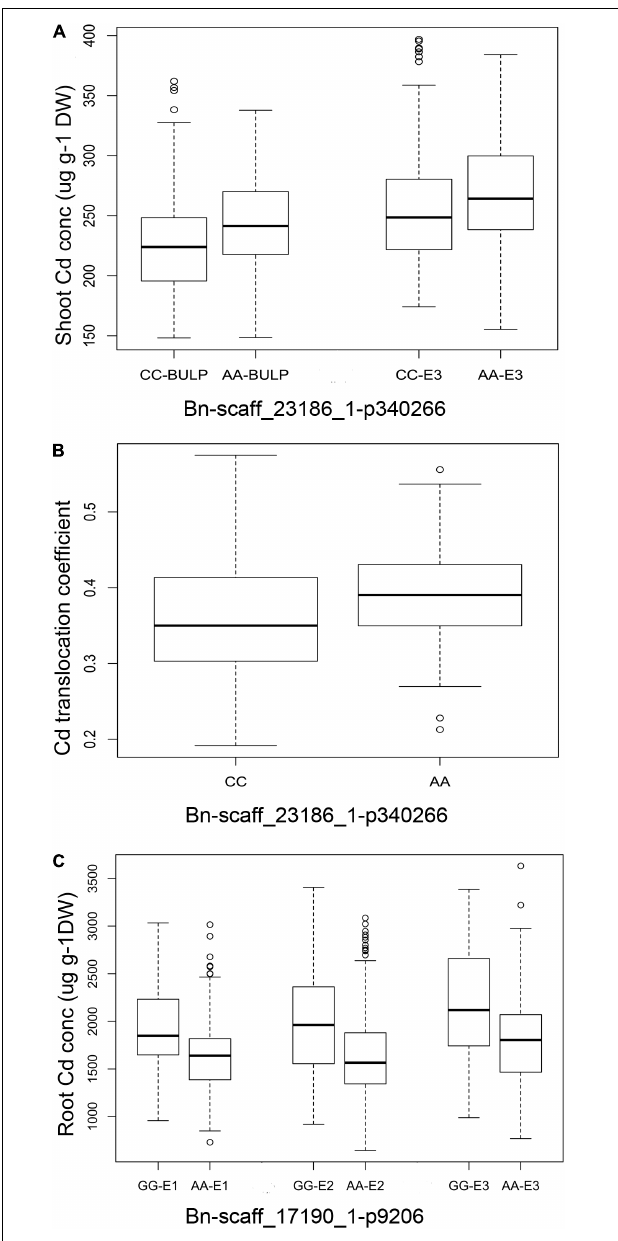
FIGURE 4 | Phenotypic differences between lines with different alleles of the SNPs associated with Cd accumulation traits in three growth environments. (A) Bn-scaff_23186_1-p340266 associated with root Cd concentration in E1 ( P < 0.001) and BLUP ( P < 0.0001). (B) Bn-scaff_23186_1-p340266 associated with Cd translocation coefficient in E1 ( P < 0.0001). (C) Bn-scaff_17190_1-p9206 associated with root Cd concentration in three environments (all P <